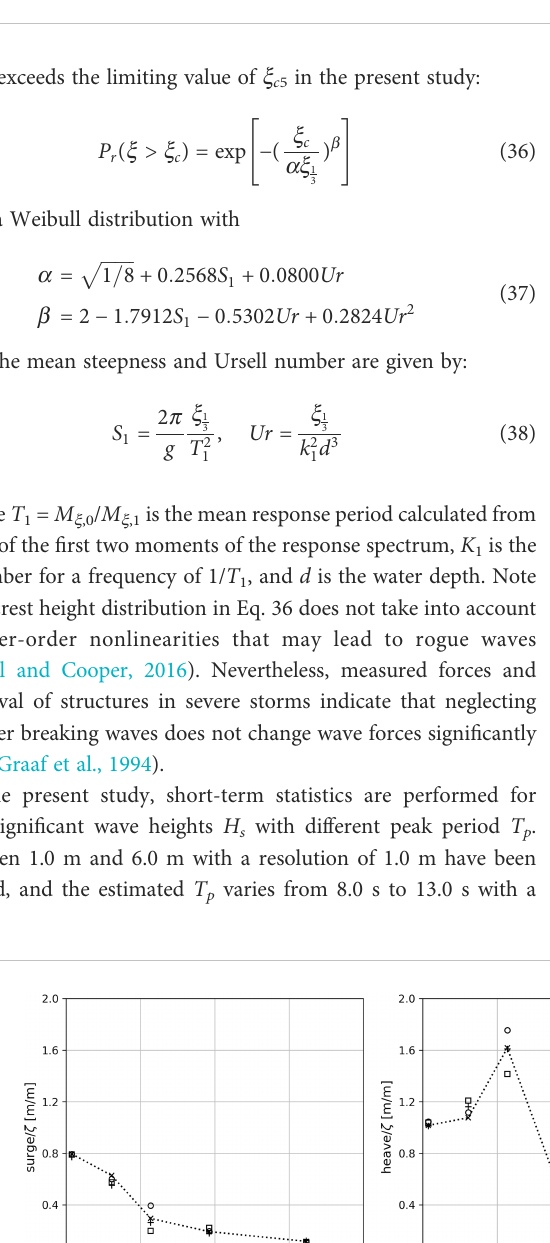
FIGURE 5 Computed and measured motion responses of a single fl oating module in head waves.